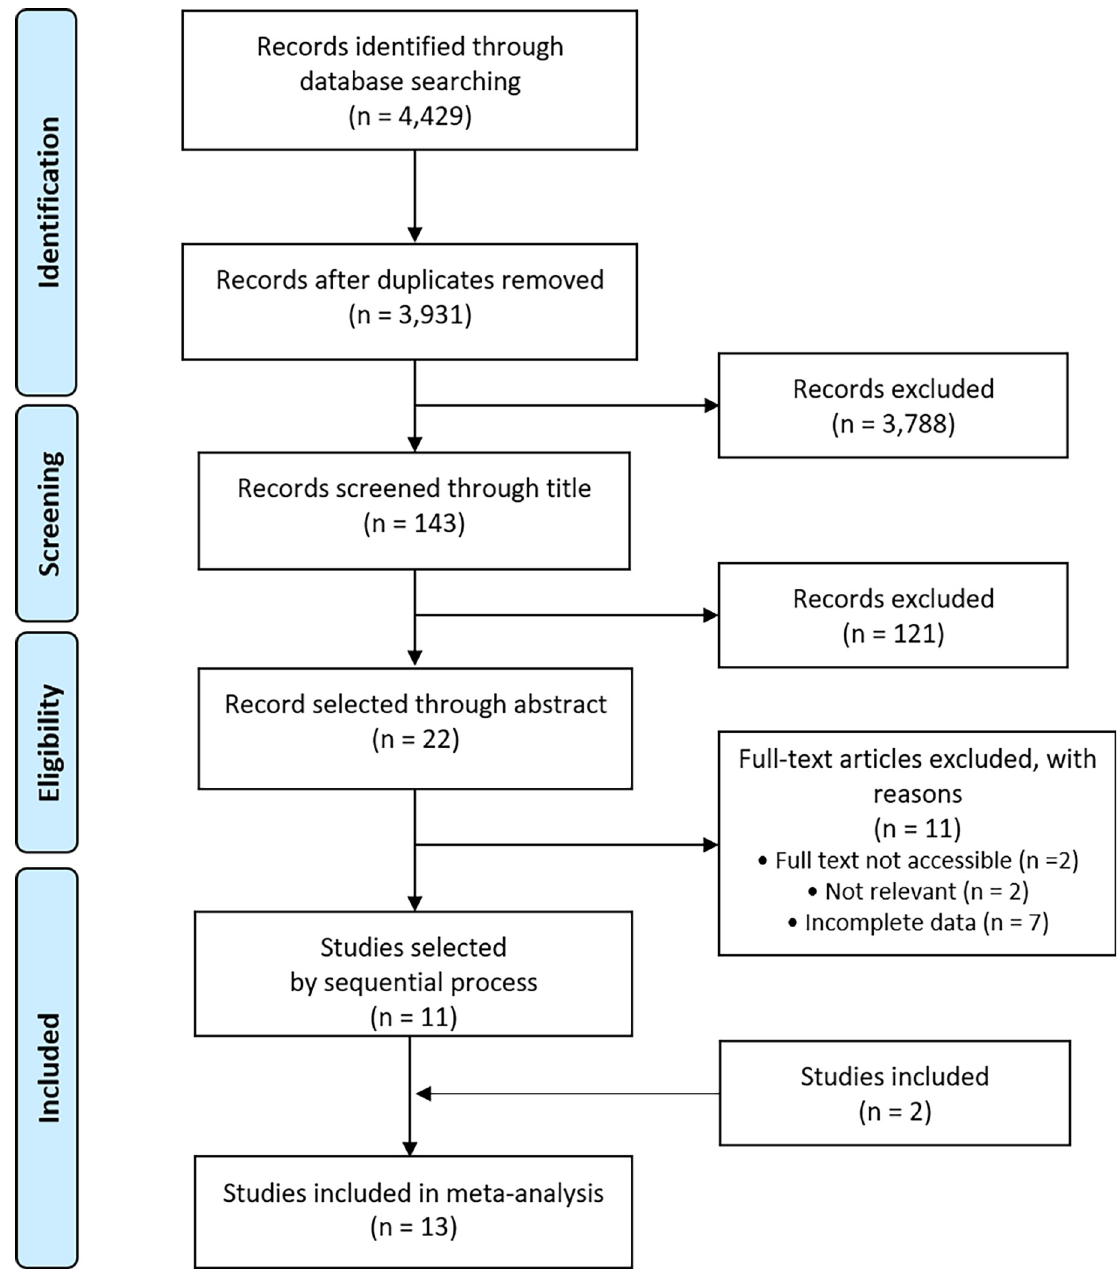
Fig 1. Flow diagram of study selection. n,